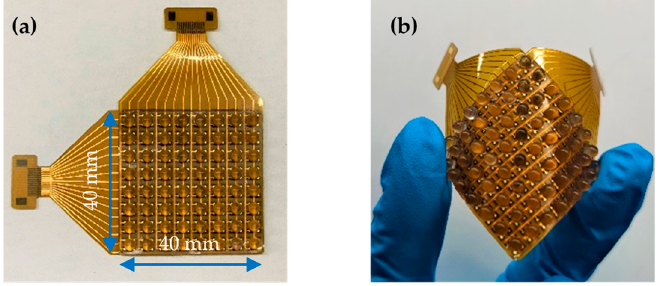
Figure 4. Illustration of the fabricated sensing array: ( a ) Placed on flat surface; ( b ) Bent by hand.